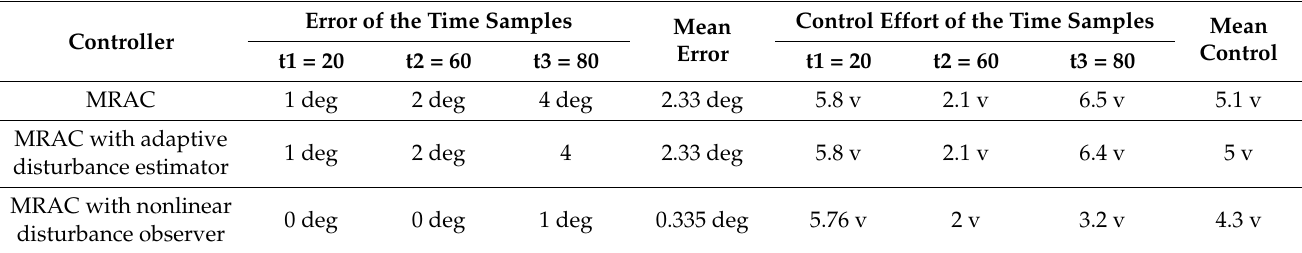
Figure 8. Position error for the three controllers. Table 2. Performance indications of the proposed controllers.